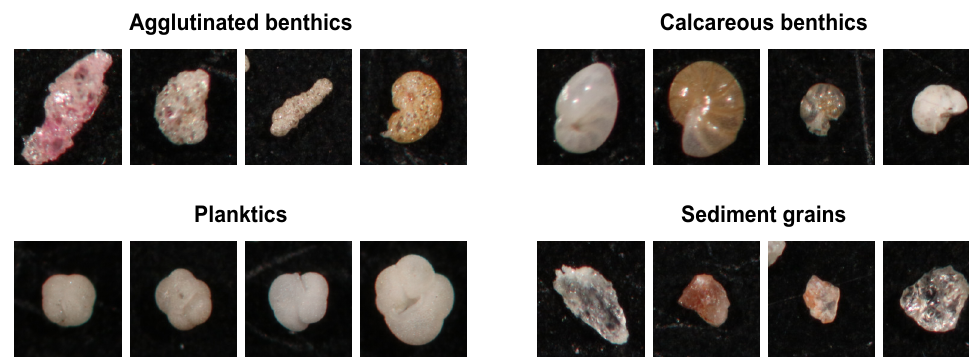
Figure 2. Examples of the four high-level classes of specimens found in the dataset.